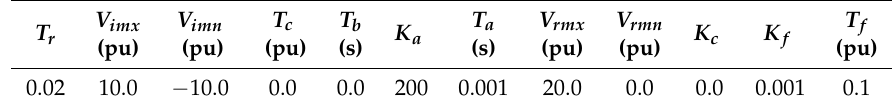
Table A2. AVR parameters (type IEEE ST1).